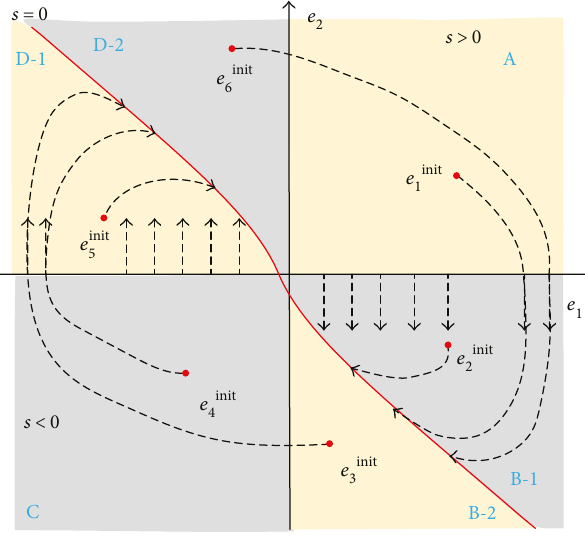
Figure 4: The relative coupling pro fi